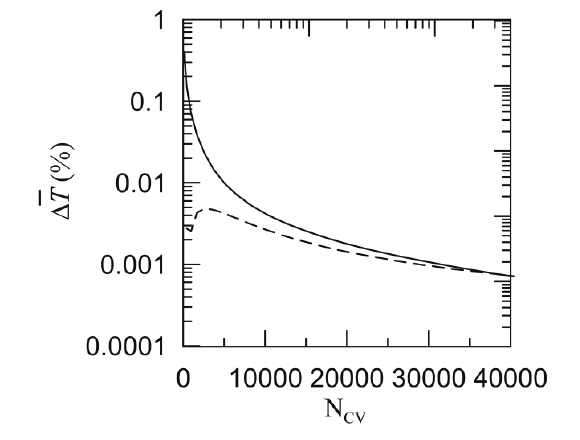
Figure 8. Numerical tests on the heat conduction equation. Percentage errors as function of the number N of control volumes of the CV computational mesh at 301 s of cooling. Solid line, between the numerical and analytical solutions. Dashed line, between the actual grid and the coarser grid computed with a grid step of 10 × 10 CVs.